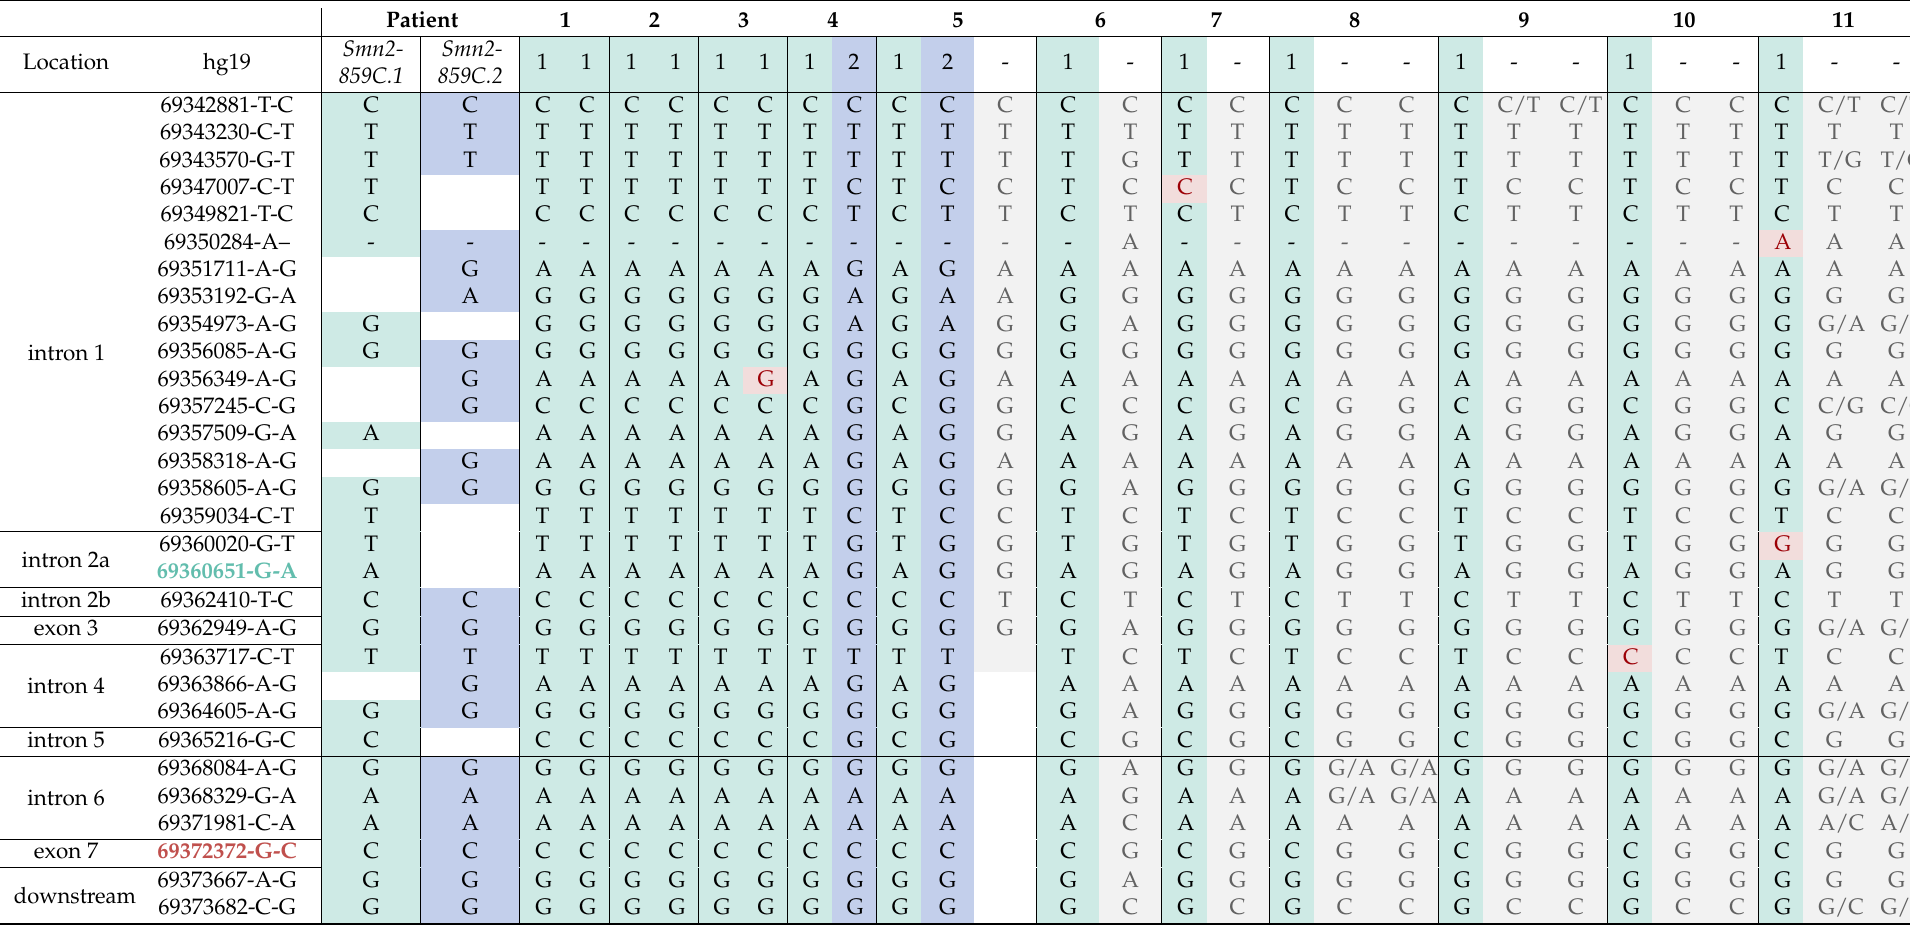
Table 2. Haplotype characterization of SMN2 genes. Detail of the 30 positions comprising the Smn2-859C.1 (green) and Smn2-859C.2 (blue) haplotypes in our patients. Punctual discrepancies are represented in red. The novel variant c.154-1141G>A (69360651-G-A, hg19/GRCh37), exclusively associated with the Smn2-859C.1 haplotype, is indicated in green in the first column. The c.859G>C modifier variant is marked in red. The remaining alleles of each patient not carrying the c.859G>C are represented in